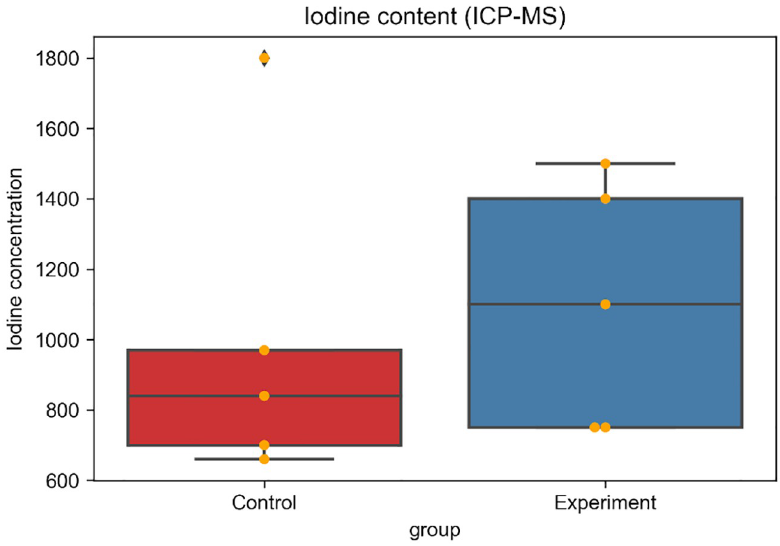
Fig 3. Iodine concentration in the tumors. The concentration of iodine (ppm) in the tumors was evaluated by inductively-coupled plasma mass spectroscopy. Orange dot represents the value in each individual.